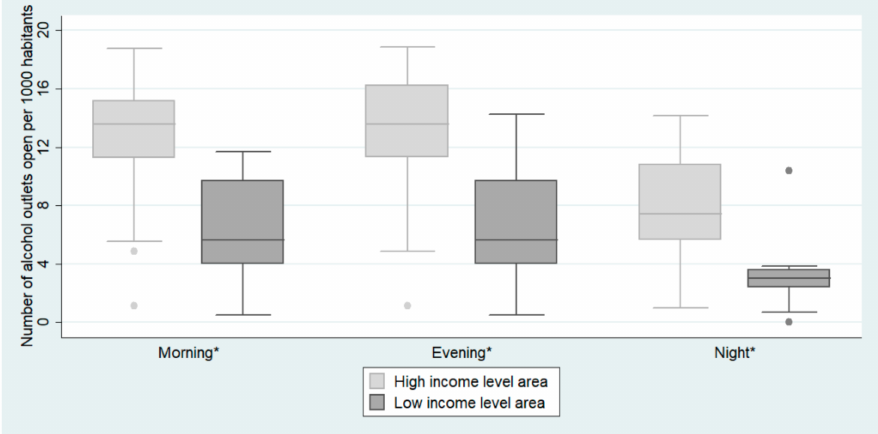
Figure 3. Distribution of the availability of alcohol according to the income level of the district in the city of Madrid, Spain, in 2018. Availability was measured as the number of outlets that were open: (1) In the morning (from 6 a.m. to 2 p.m.); (2) In the evening (from 3 p.m. to 10 p.m.); (3) At night (from 11 p.m. to 5 a.m.); per 1000 inhabitants. * Significant di ff erences. p -values were estimated with a Wilcoxon test between the high-income level area (leisure area) and low-income level area (residential area) with a level of confidence of